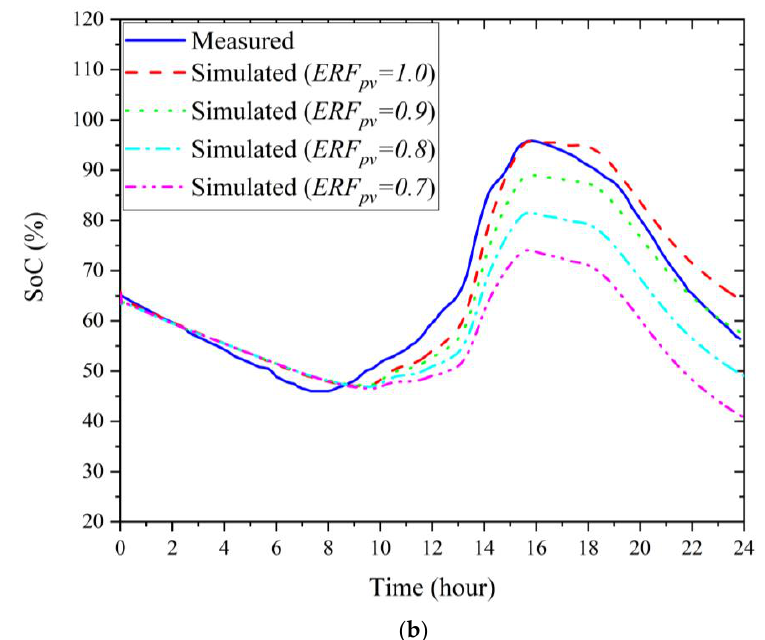
Figure 26. Validation results of PV and the battery storage system: ( a ) PV output power; ( b ) battery SoC% (cloudy sky during the whole day).